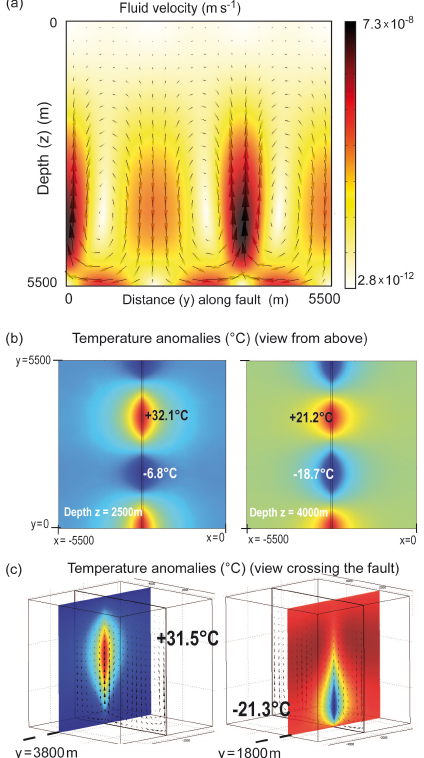
Figure B2. Details of the 3D benchmark experiment in Fig. B1. (a) Field velocity and values within the fault; (b) lateral diffusion of temperature anomalies at depths of 2500 and 4000m; (c) lateral diffusion of hot and cold anomalies perpendicular to the